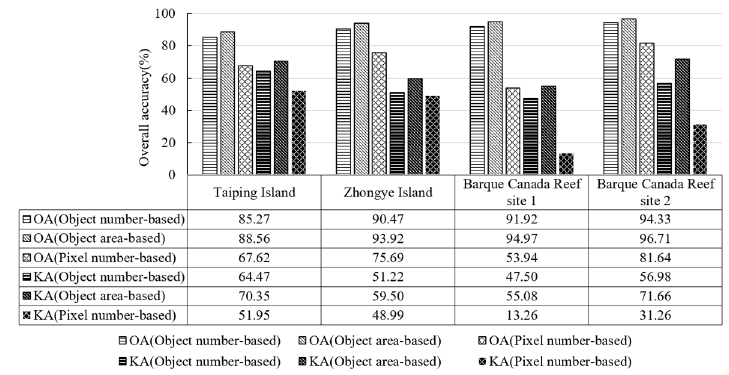
Figure 6. Overall accuracy and Kappa coefficients of the PBCD and OBCD results of the four study sites.